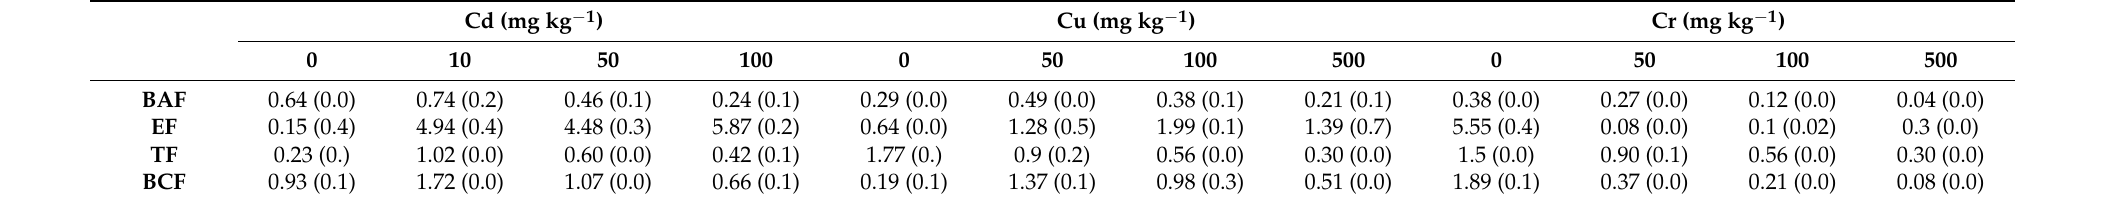
Table 2. Values of related metal accumulation factors. Results shown as mean ±